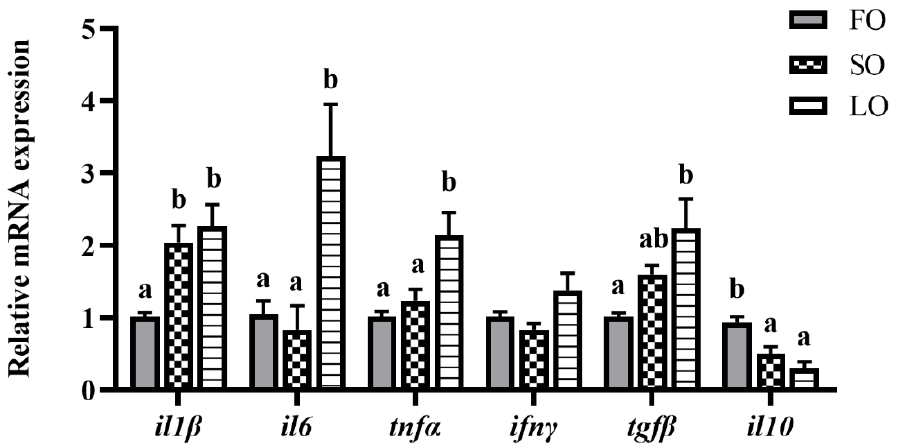
Figure 4. Effects of dietary SO and LO on the mRNA expression of inflammatory-response-related genes in adipose tissue of large yellow croaker. Results are presented as the means ± S.E.M. and were analyzed using Tukey’s test (n = 4). Bars labeled with the same letters are not significantly different ( p > 0.05; no difference between the unlabeled bars).